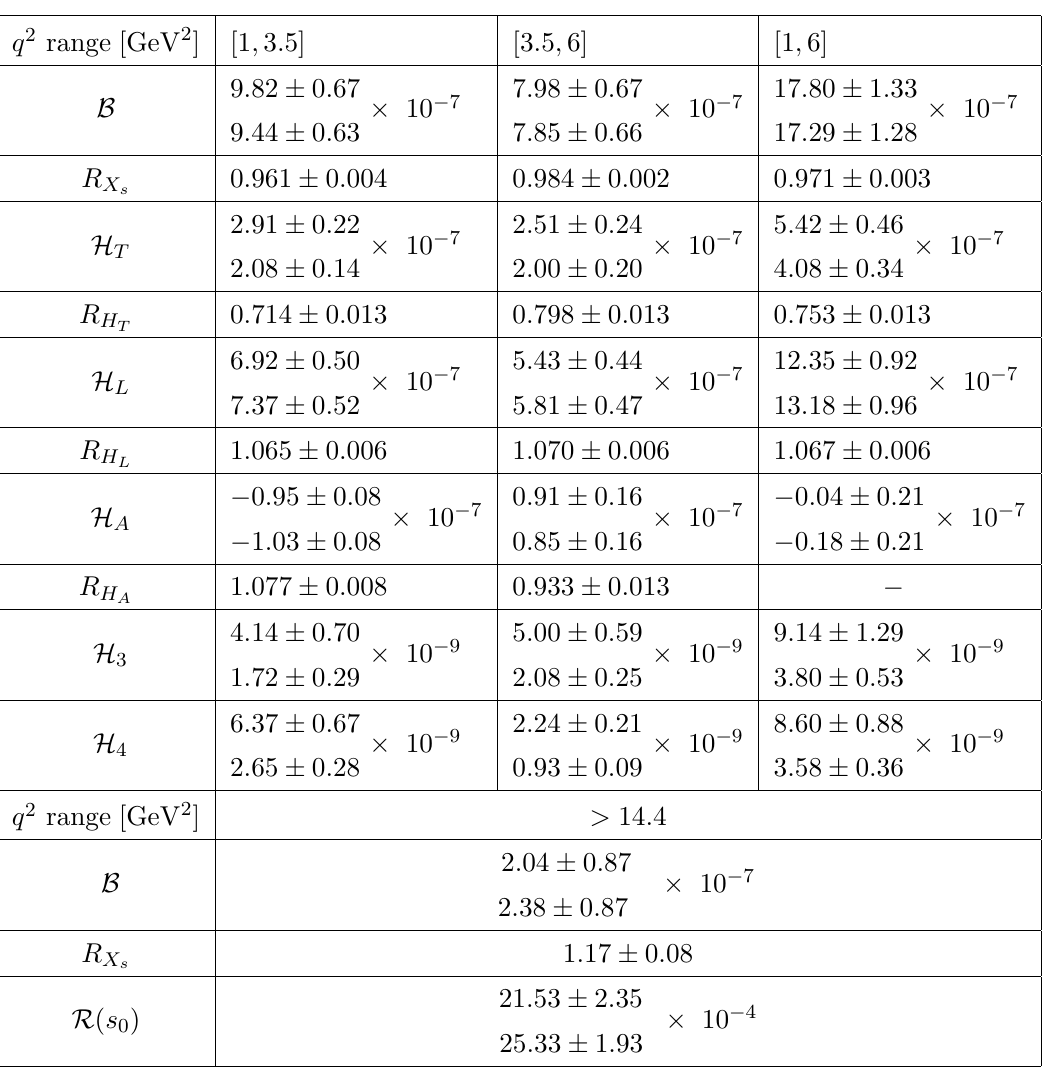
Table 2 . Summary of the numerical results for the di(cid:11)erent observables. If applicable, the (cid:12)rst entry in each row is for electrons, the second for